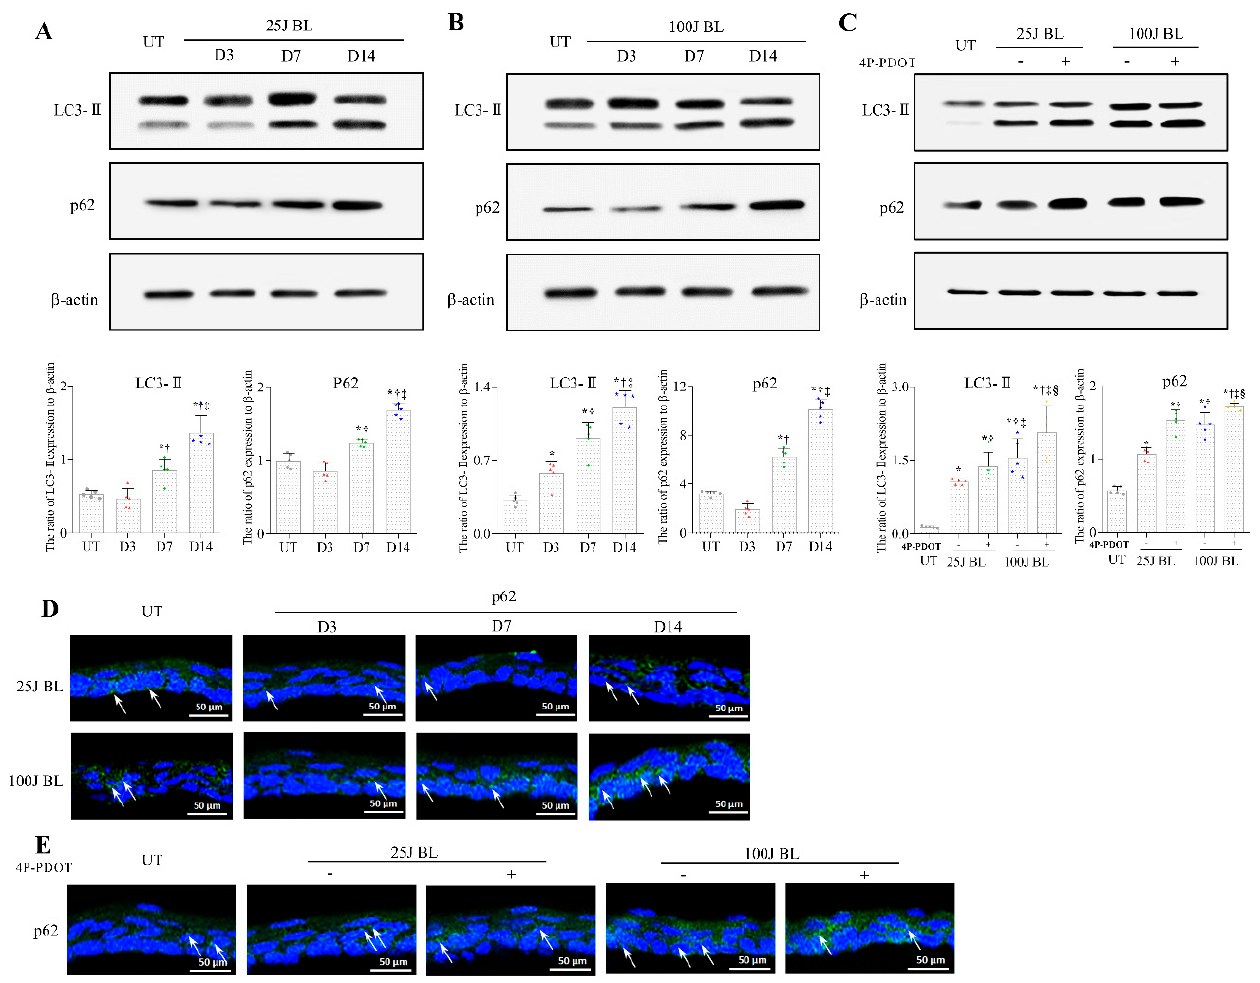
Figure 5. Western blotting ( A – C ) for the expression of LC3- Ⅱ and p62 and IHC ( D , E ) for p62 expression in the cornea of the UT, 25J BL, 25J BL+4P-PDOT, 100J BL, and 100J BL+4P-PDOT groups after 14 days of BL exposure. ( A , B ) * p < 0.05 vs. UT, † p < 0.05 vs. D3, ‡ p < 0.05 vs. D7; ( C ) * p < 0.05 vs. UT, † p < 0.05 vs. 25J BL, ‡ p < 0.05 vs. 25J BL+4P-PDOT, § p < 0.05 vs. 100J BL; UT, untreated; BL, blue light.